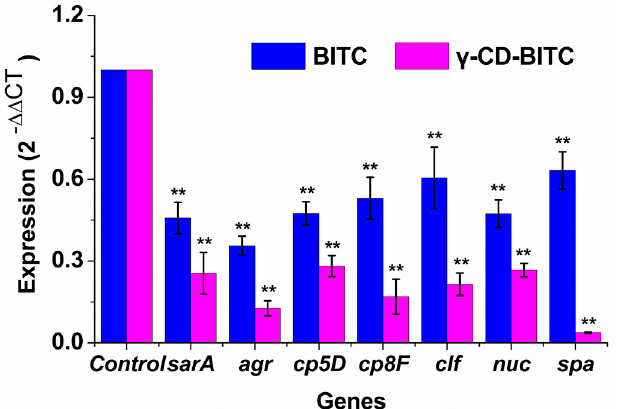
Figure 5. Effects of BITC and γ -CD-BITC on virulence gene expression in S. aureus . Relative expres- sion of sarA , agr , cp5D , cp8F , clf , nuc , and spa compared to 16S rRNA after normalization to one control. The data were calculated using the average of three independent replicates. ** Differences in gene expression were significant ( p < 0.01).